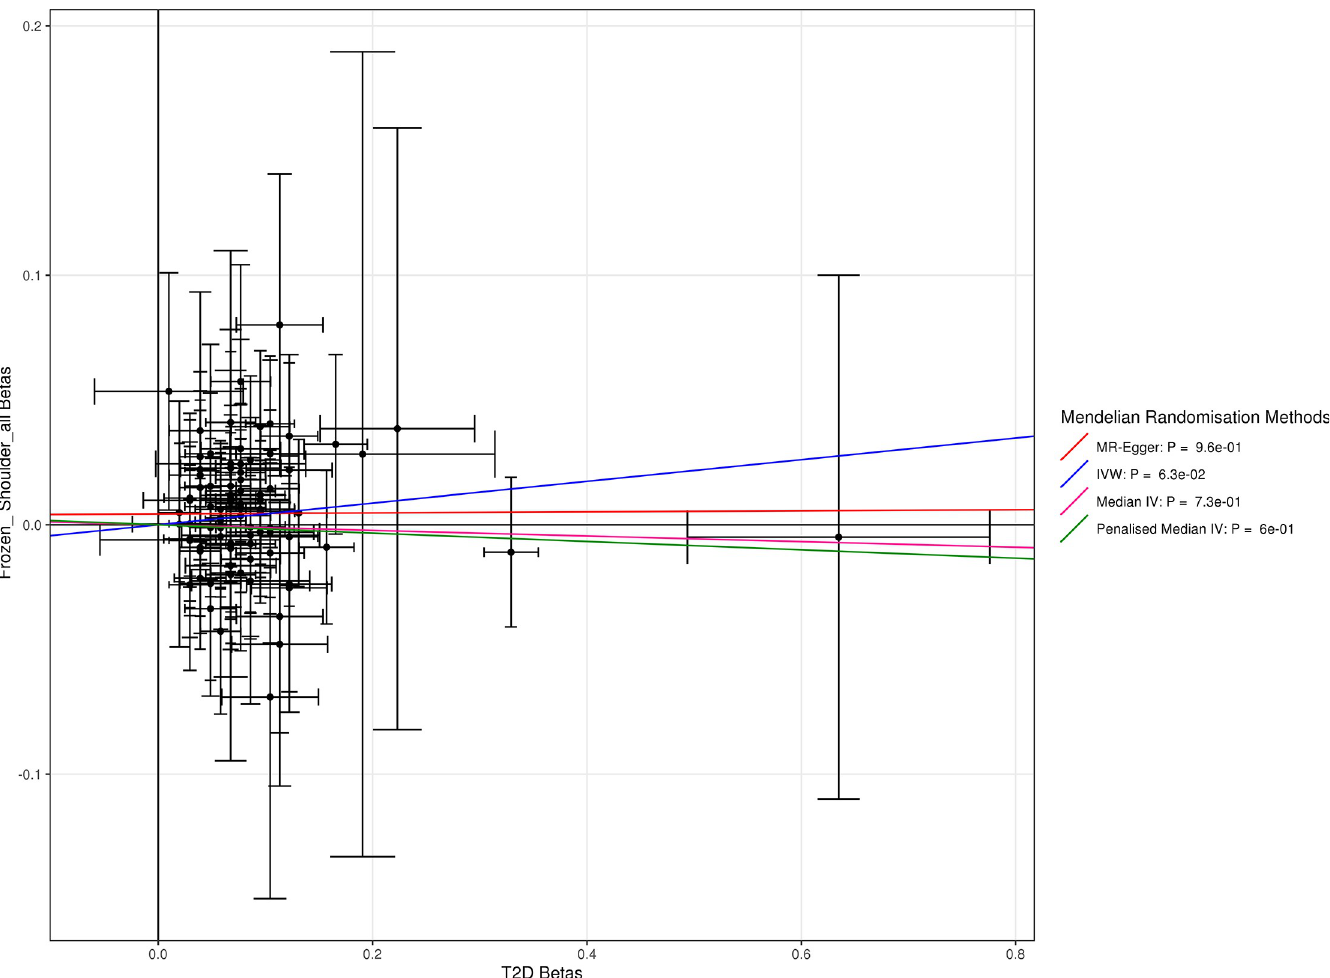
Fig 3. Two Sample Mendelian Randomization Results, showing for each SNP in the Type 1 Diabetes GRS in [20], the log-odds ratio for type 2 diabetes on the x axis and the log-odds ratio for frozen shoulder (defined by ICD-10, OPCS and GP records) on the y axis.